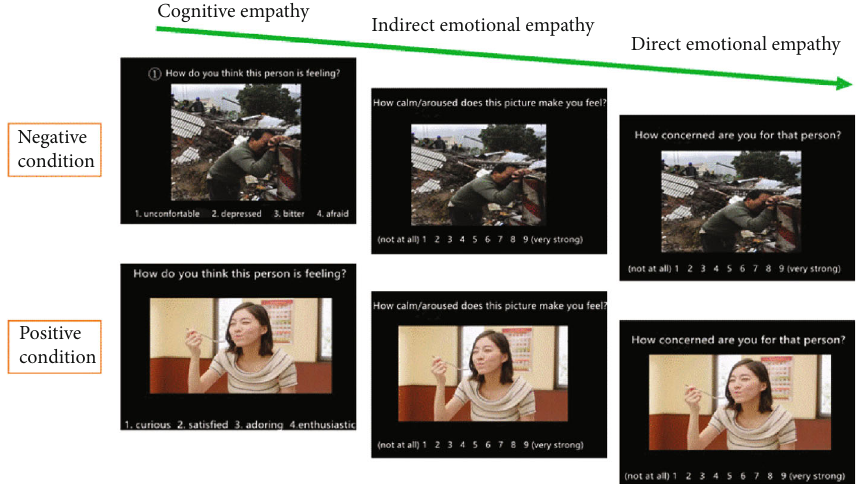
Figure 2: Example items of the